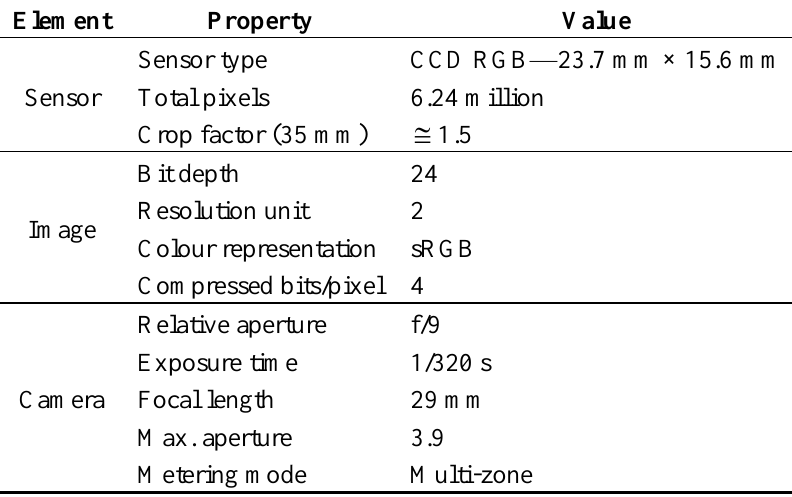
Table 1. Several important characteristics of the camera sensor, the images taken and the setting of the camera used in the acquisition process.